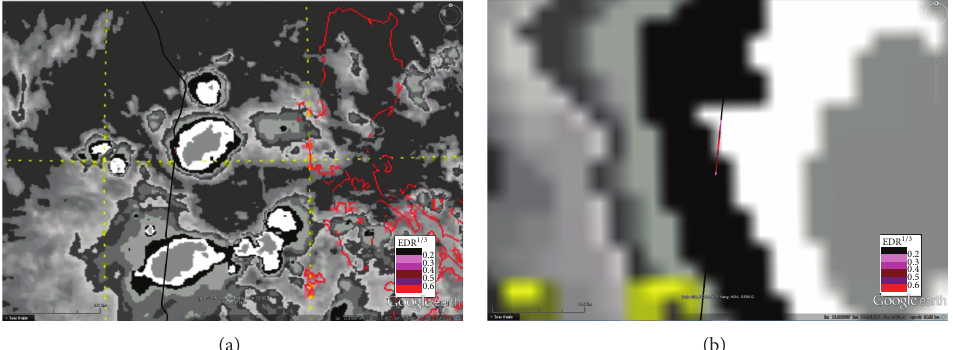
Figure 6: Similar to Figure 5 but for EDR 1/3 , (b) shows a zoom-in of (a) around the location of the turbulence